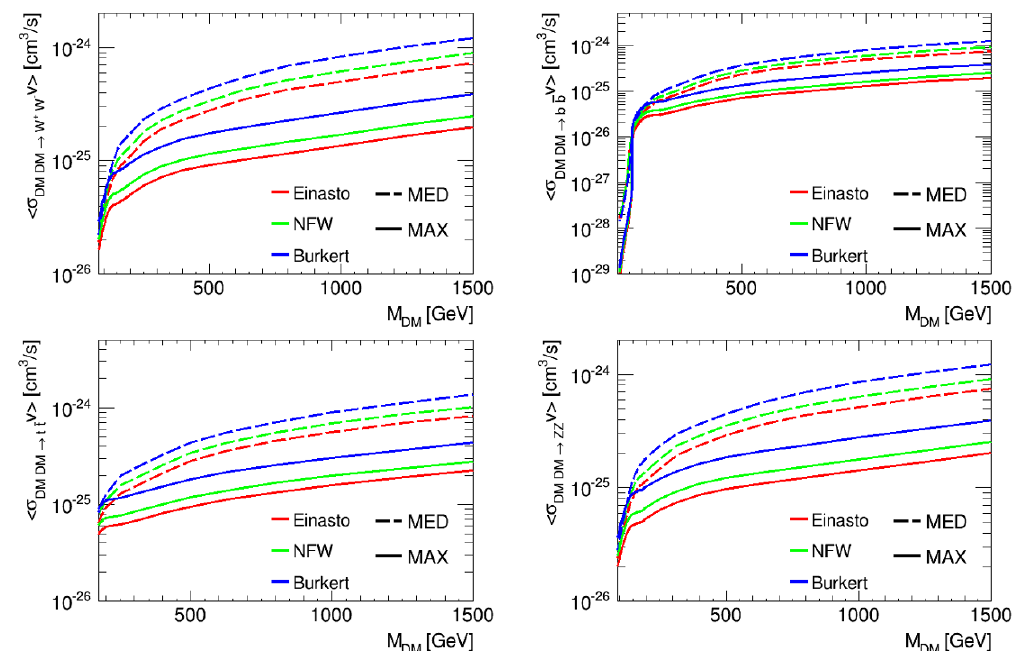
Figure 1 . 95% C.L. upper limit of the neutralino annihilation cross section into W + W (cid:0) (upper left), b (cid:22) b (upper right), t (cid:22) t (lower left) and ZZ (lower right), derived from AMS-02 antiproton data. scheme described in section 2.2.2 for the Med and Max sets of propagation